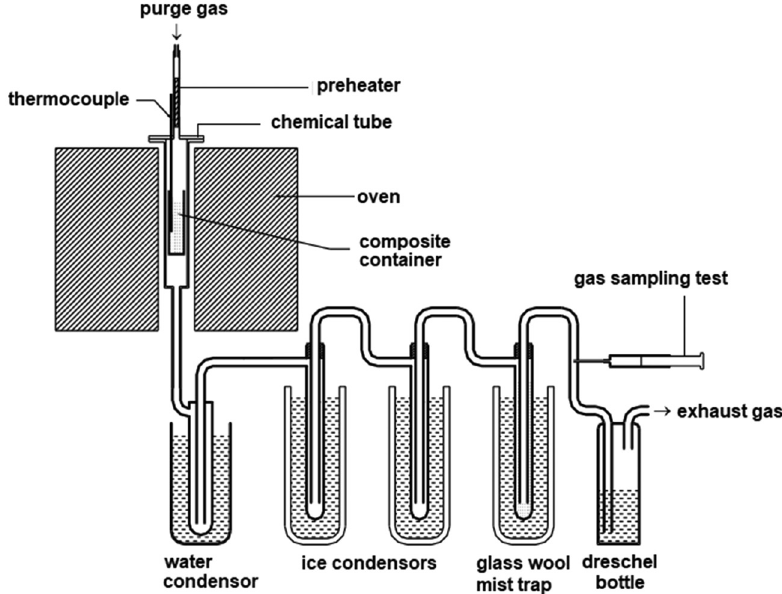
Figure 14: Pyrolysis reactor scheme [ 74 ]